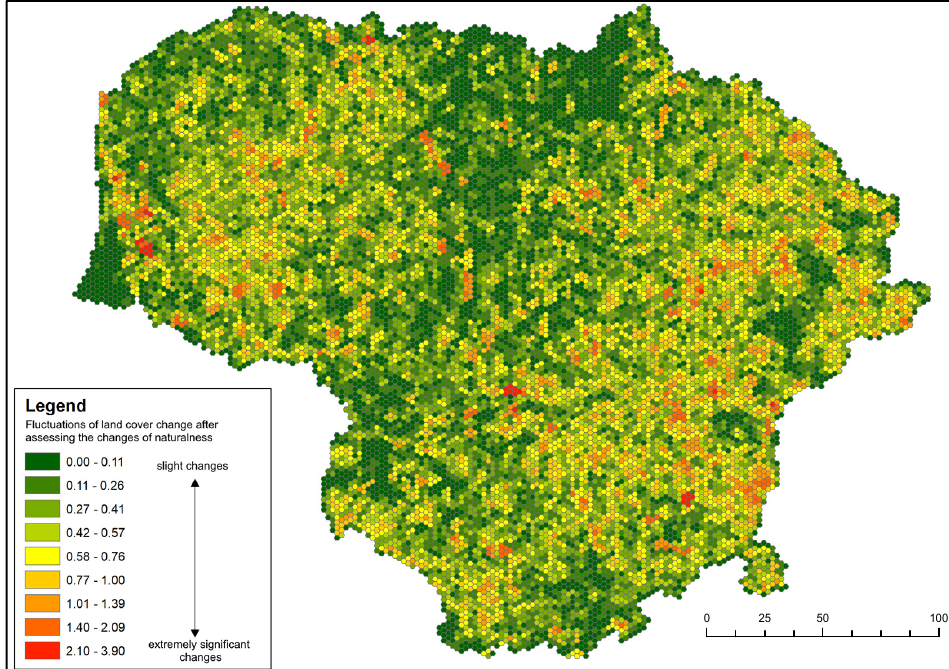
Figure 5. Fluctuations in land-cover change in Lithuania, 1995–2018.